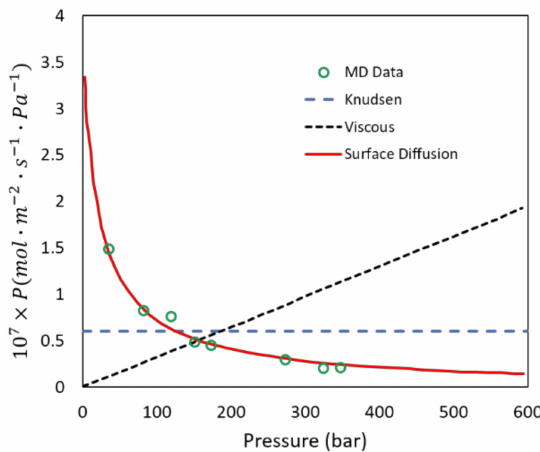
Figure 7. Simulation data on permeance of N 2 at 322 K in an equimolar N 2 /O 2 mixture as a function of pressure. Note that except for surface diffusion, the two other mechanisms are clearly qualitatively